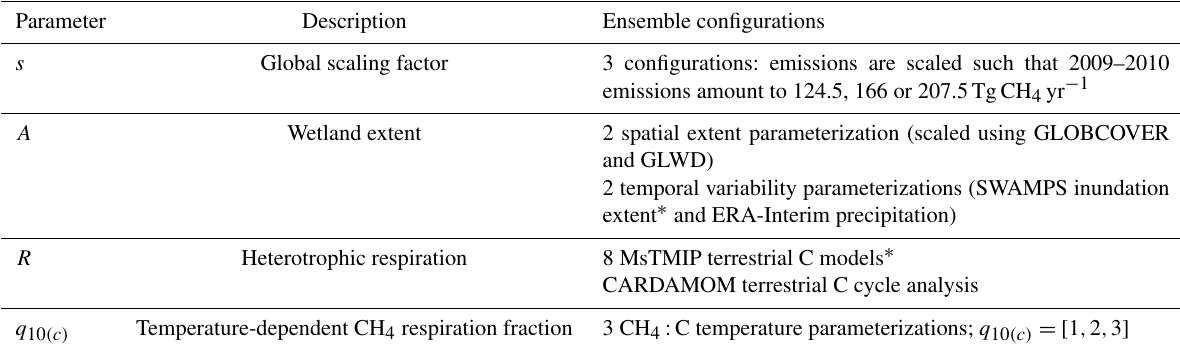
Table 1. Wetland CH 4 model ensemble